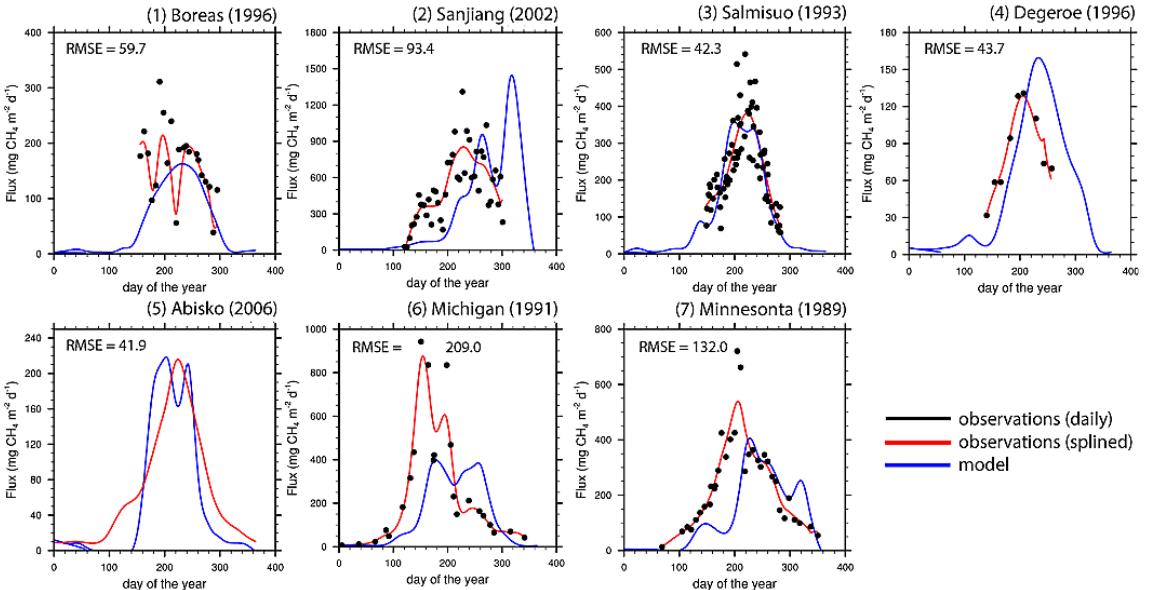
Fig. 2. Daily methane emissions measured at seven sites compared to LPJ model output analogue to a previous model calibration (Wania et al., 2010). All our model runs use the same optimised parameter set for all sites. The respective root-mean-square errors (RMSE) calculated from daily differences between spline fits through the measurements and model output over the period where the measurements exist are given in the top left corner of each box. Note that at the Degeroe site ebullition was not measured and was, therefore, also excluded in the model output. The Abisko record is the only one with daily measurements and only the spline fit is plotted for the purpose of better clarity. Model results are plotted as smoothing spline function with a cut-off period of two months (blue line), observations are plotted as daily values (black dots) and a smoothing spline function with a cut-off period of two months (red line). Note the different scales on the